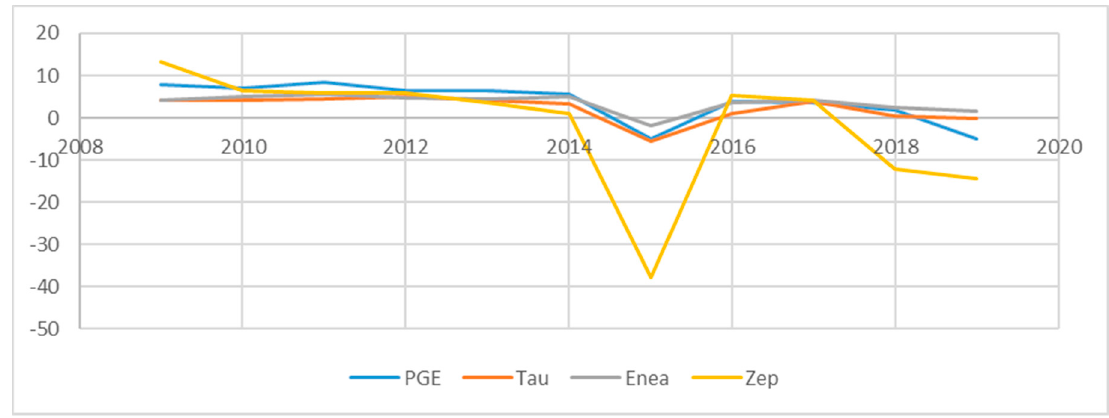
Figure 2. ROA ratios for the analyzed companies in 2009–2019 (%). Source: Own elaboration.